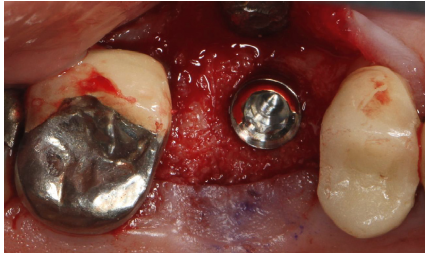
Figure 8: A 4.7/11mm endosseous implant was placed at site #3 with the use of osteotome sinus floor elevation technique.